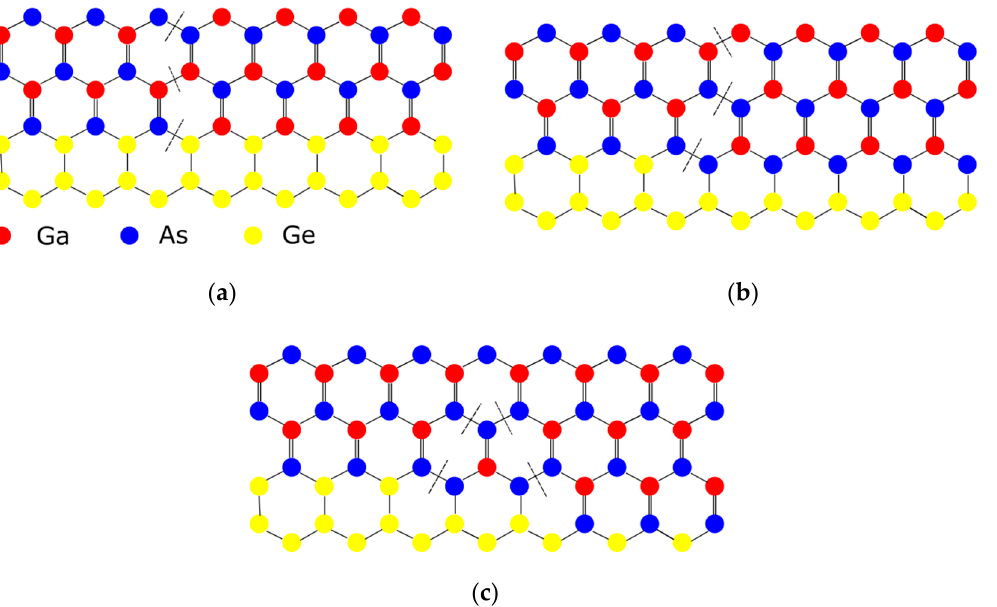
Figure 45. Antiphase boundaries (APDs) occurs when ( a ) GaAs is grown on an incomplete pre-layer coverage Ge substrate or with ( b ) odd atoms layer step, and ( c ) self-annihilating of APDs when GaAs is grown on cut-off